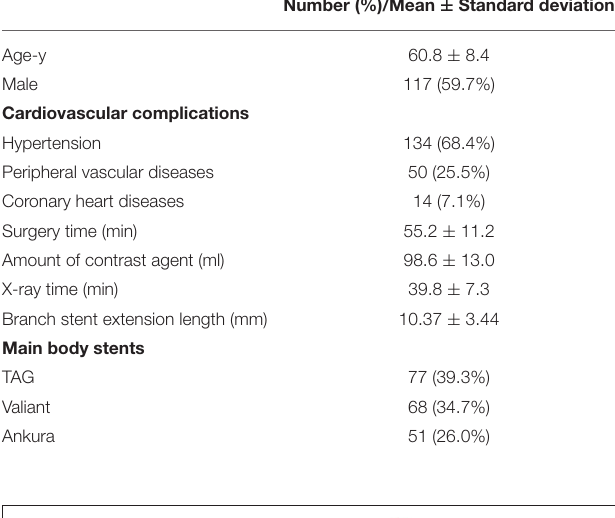
TABLE 1 | Patient characteristics and baseline.